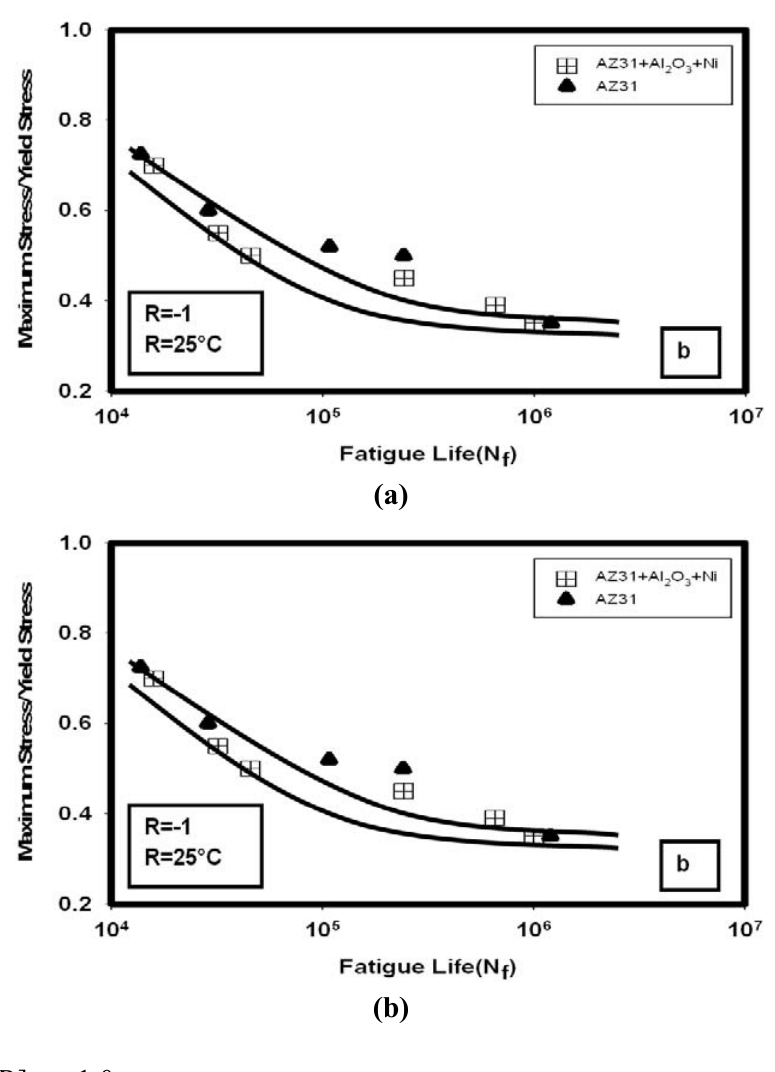
Figure 5. Comparison of the variation of ratio of maximum stress to yield stress with ) of the dual particle reinforced magnesium alloy (AZ31 + Al fatigue life (N f the unreinforced matrix alloy (AZ31) cyclically deformed at room temperature (T = 25 °C) at: ( a ) Load ratio of 0.1; ( b ) Load ratio of −